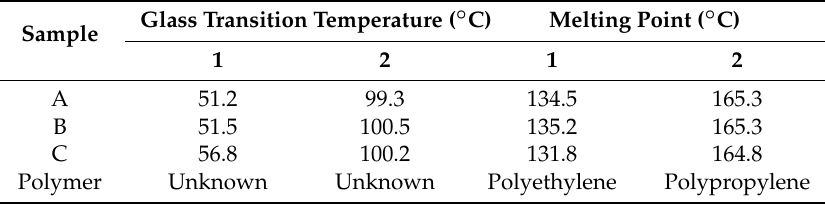
Figure 5. Differential scanning calorimetry (DSC) traces for three locations within the re-formative block (this study). Table 3. Measured glass transition and melting temperatures measured at the three locations, A, B, and C (this